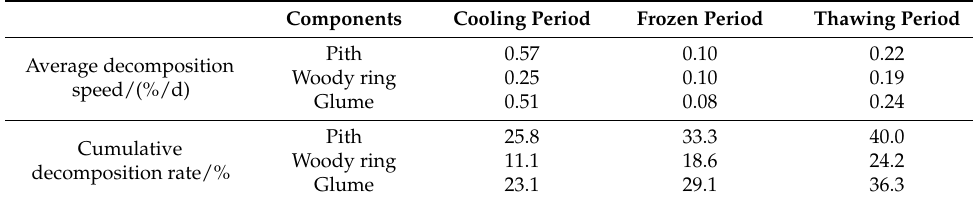
Table 2. Average decomposition speeds and cumulative decomposition rates of corn cob components.